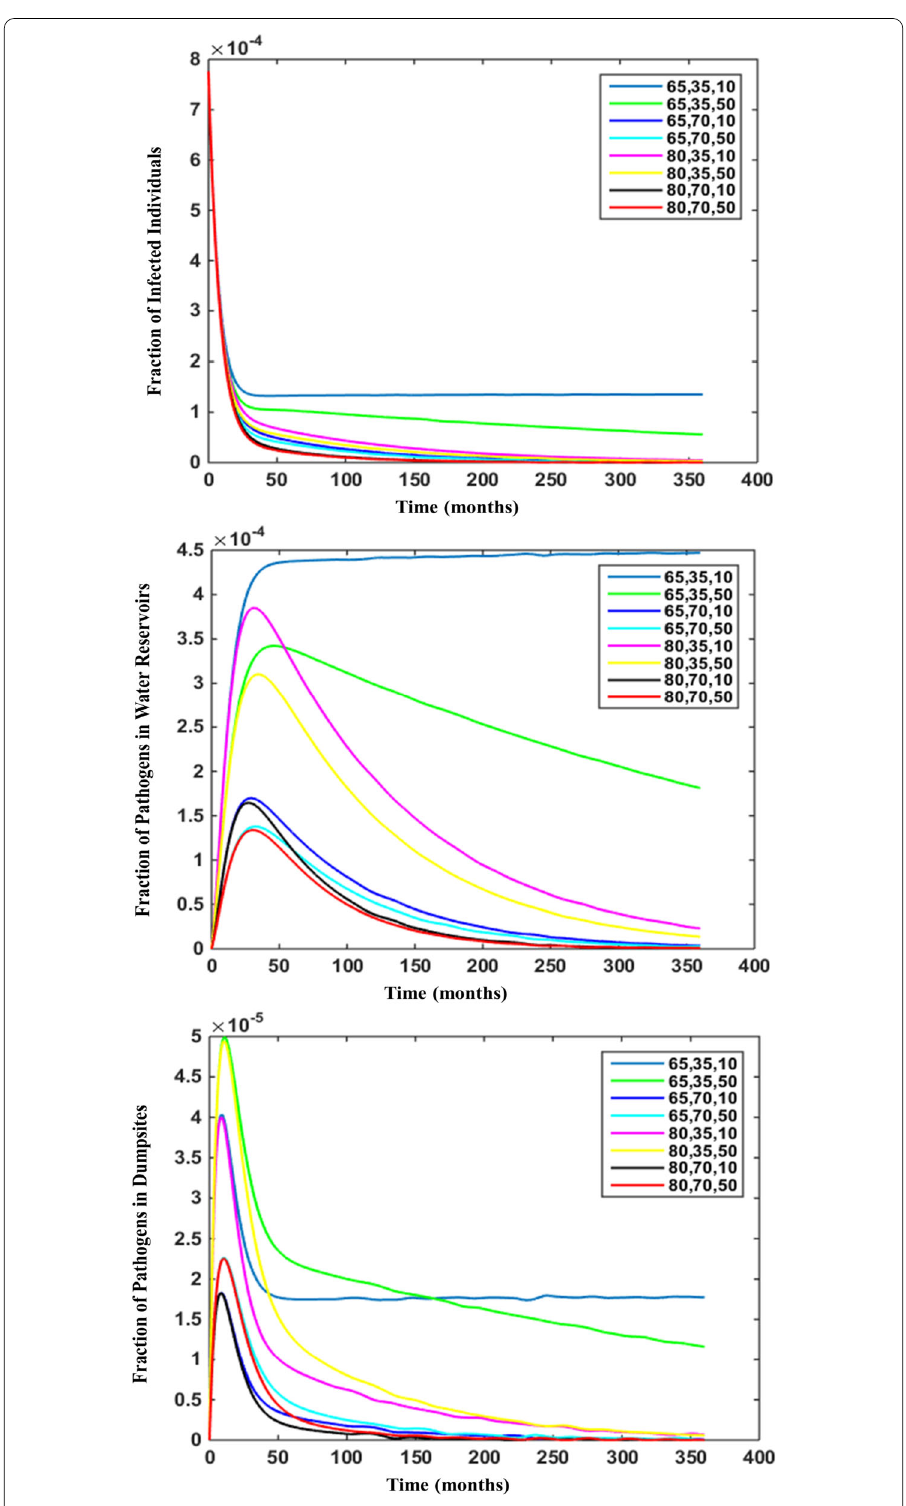
Figure 7 Effects of improving DWS, WST, and MSW services coverage ( r 1 , r 2 , and r 3 ) on the fraction of infected individuals and the fraction of pathogens in water reservoirs and dumpsites that are predicted by model